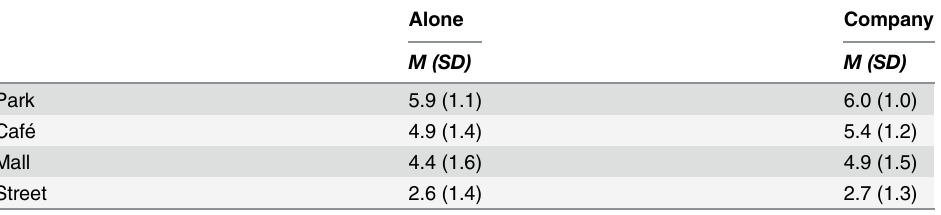
Note : Scores fall on a scale from 1 = not at all positive to 7 = very positive.